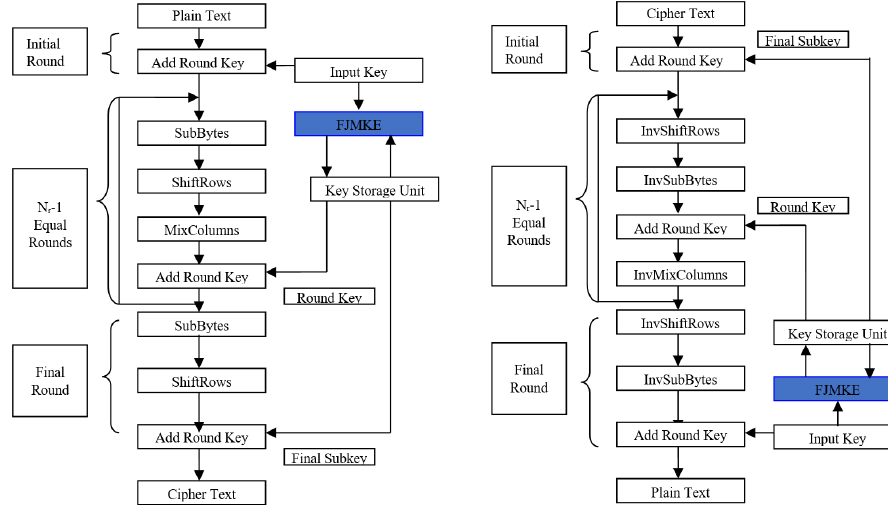
Figure 2. Architecture of AES-FJMKE.